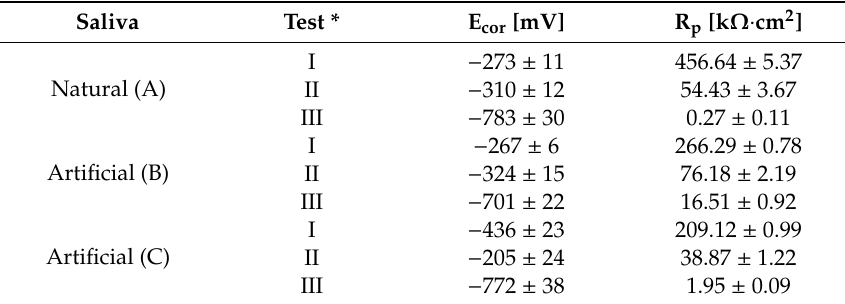
Table 4. Results of corrosion and fretting corrosion